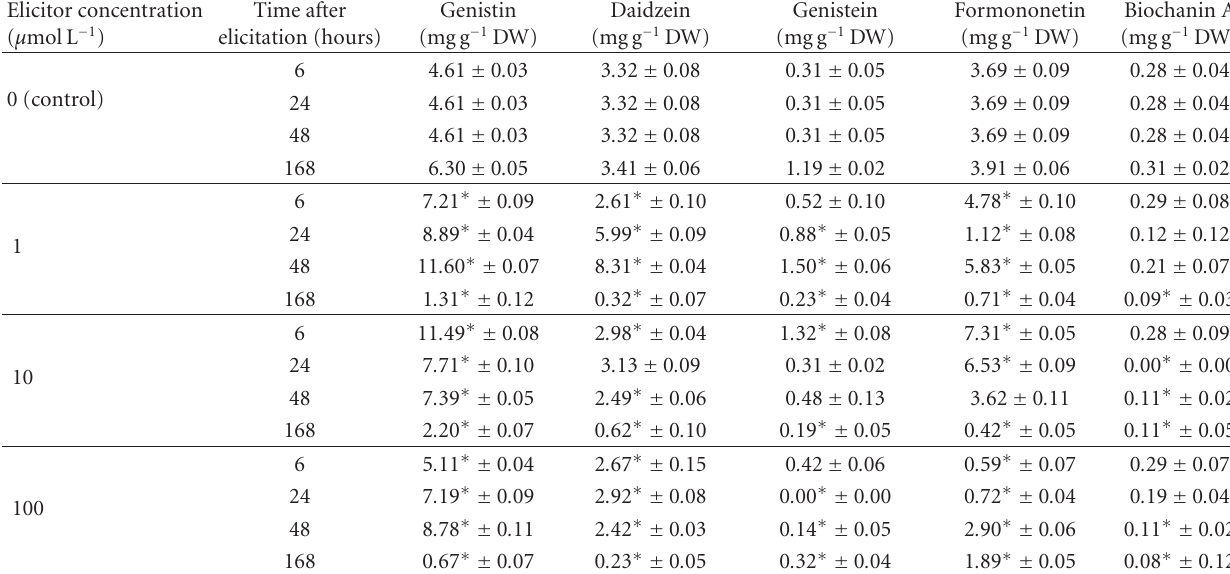
Table 1: Production of isoflavonoids in the suspension culture of Trifolium pratense . Elicitor concentration